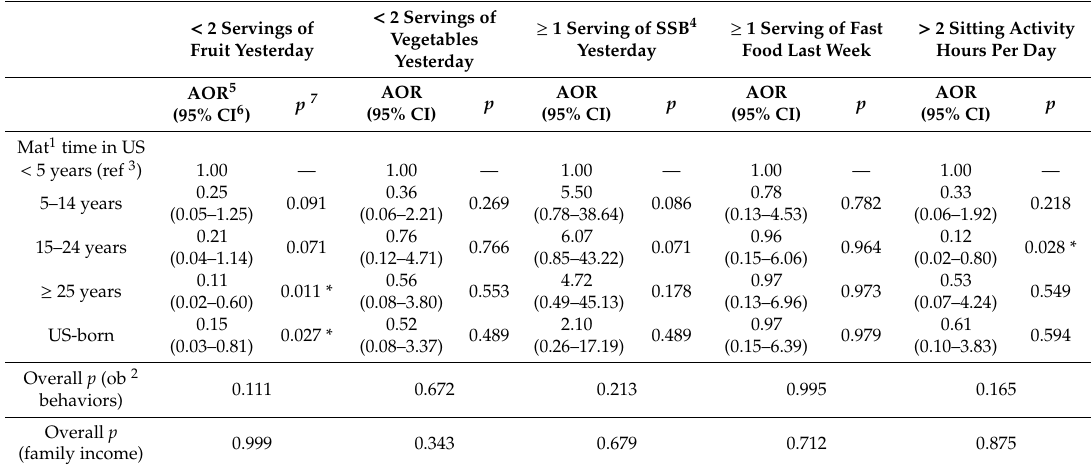
Table 4. Association between maternal time in the US and obesogenic behaviors among Asian American children ages 2 to 11 years old (n = 609): CHIS